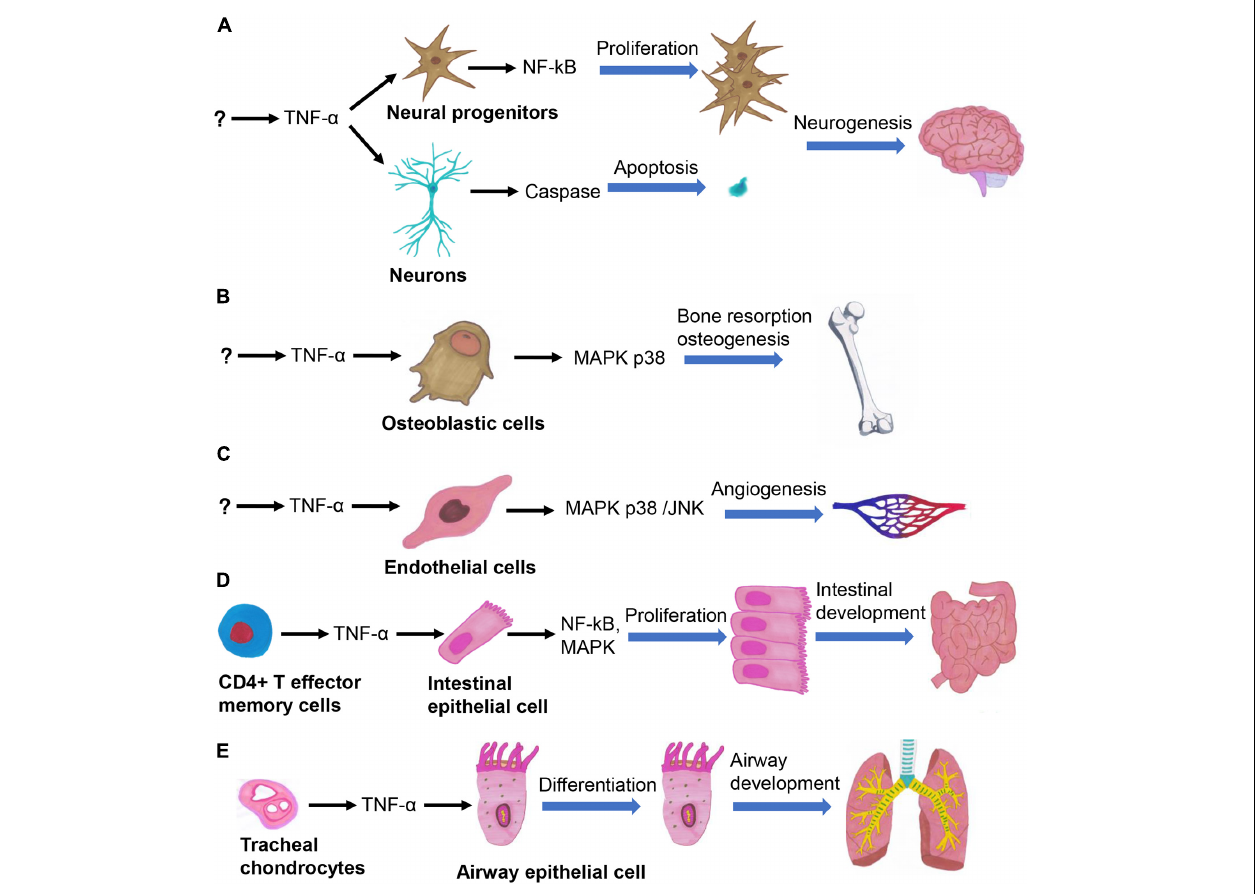
FIGURE 1 | TNF- α regulates several important biological processes in organogenesis, such as the neurogenesis (A) , osteogenesis (B) , angiogenesis (C) , intestinal development (D) , and airway development (E)